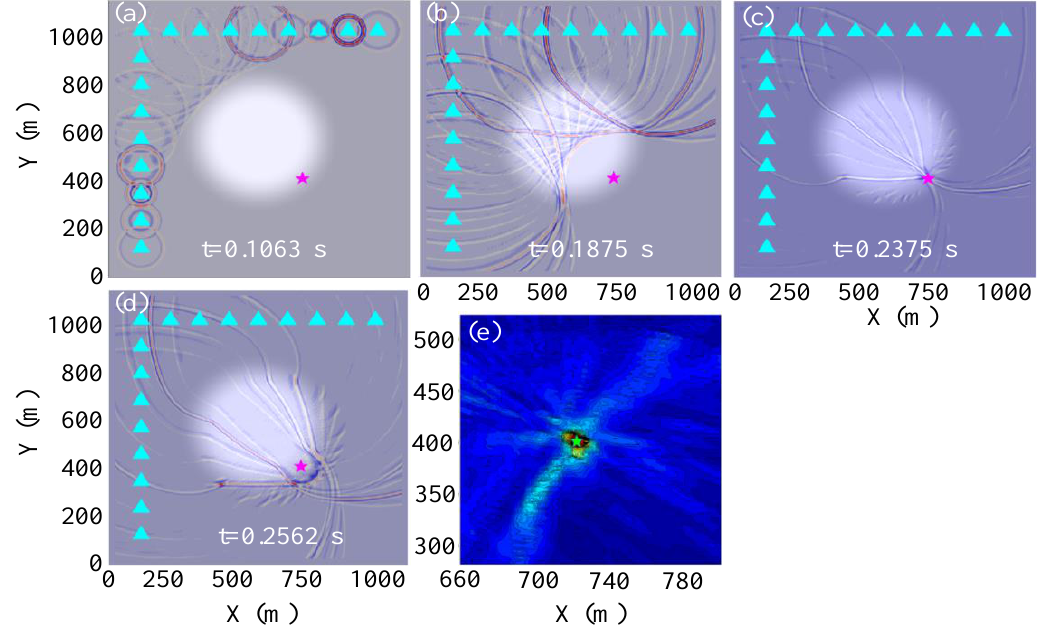
Figure 5. Location results of the GBRTM location method when using synthetic waveforms from the realistic blasting event 1. ( a ) t = 0.1063 s; ( b ) t = 0.1875 s; ( c ) t = 0.2375 s; ( d ) t = 0.2562 s; ( e ) Stacking amplitude imaging of back propagation wavefields at points near the true source based on autocorrelation imaging condition. The rest of the instructions are the same as in Figure